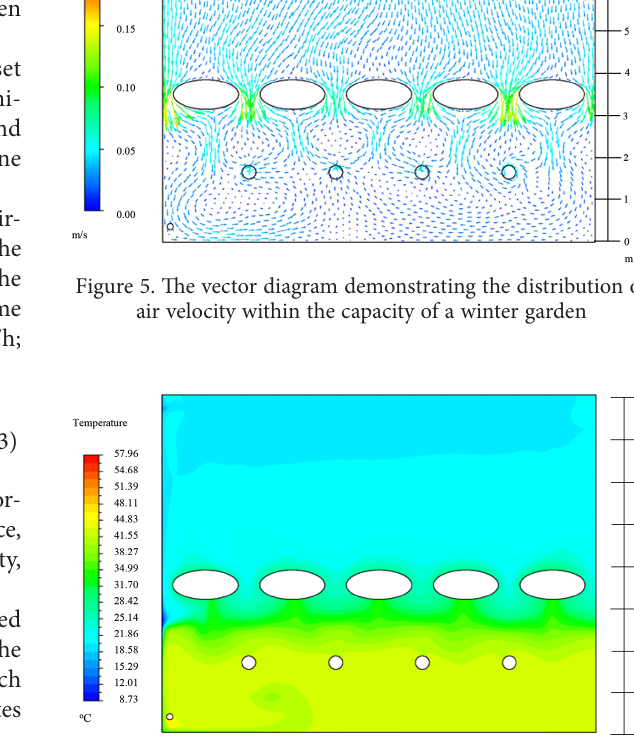
Figure 6. The diagram of distribution of temperature within the capacity of winter garden